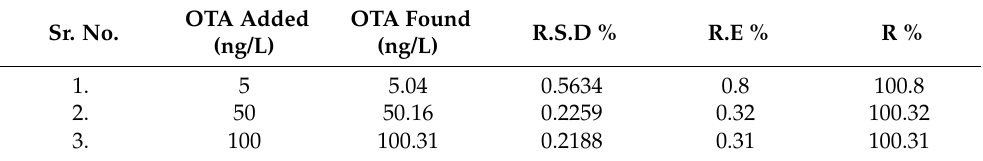
Table 2. Determination of OTA spiked in rice extract (n = 3). OTA Added OTA Found R.S.D % R.E % R % Sr. No. (ng/L) (ng/L) 1.